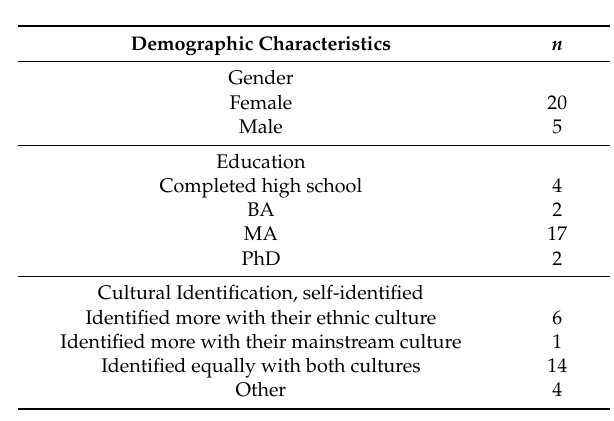
Table 1. Demographics of the Sample in the